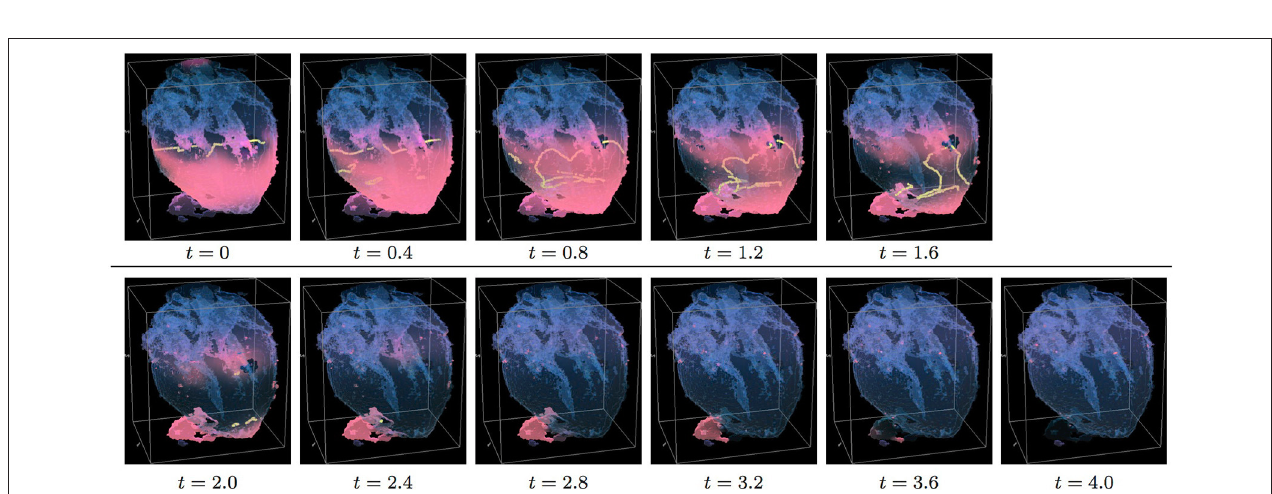
FIGURE 6 | Anisotropic whole heart simulation. The translucent fetal heart is shown in blue, excitation front shown in red (see the color box in Figure 3 ), the yellow lines are the instant organizing filaments of the excitation vortices; time shown under each panel in time units of Equations (1, 2). The anisotropy of the heart causes the fast transient distortion of the organizing filament of the initial excitation vortex, followed by the fast drift and self-termination at the apex of the heart (See Supplementary Video 6 ).